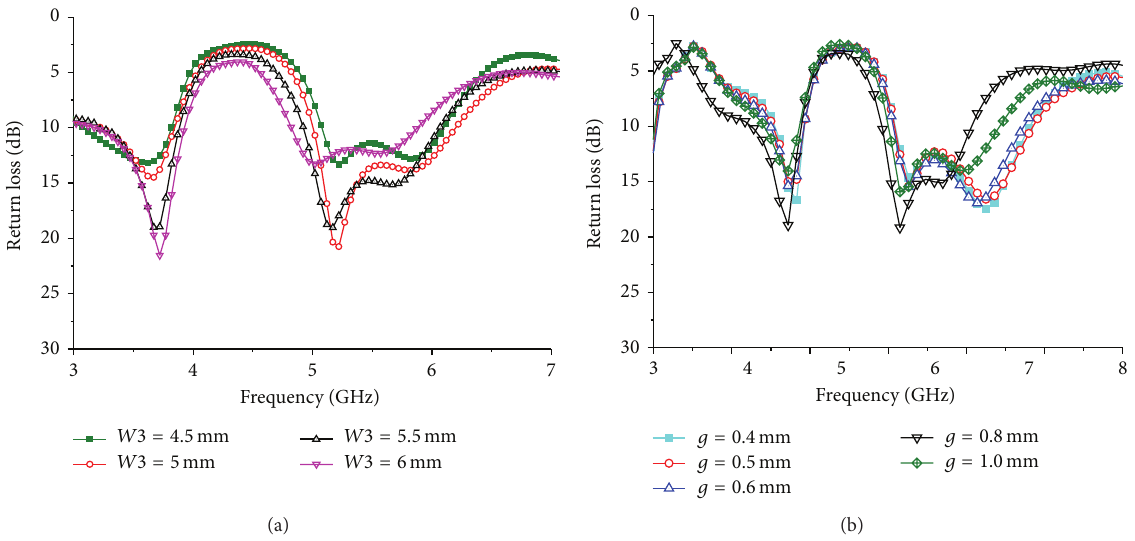
Figure 6: Parametric studies of (a) ground plane slot 𝑊3 and (b) CPW gap 𝑔 .